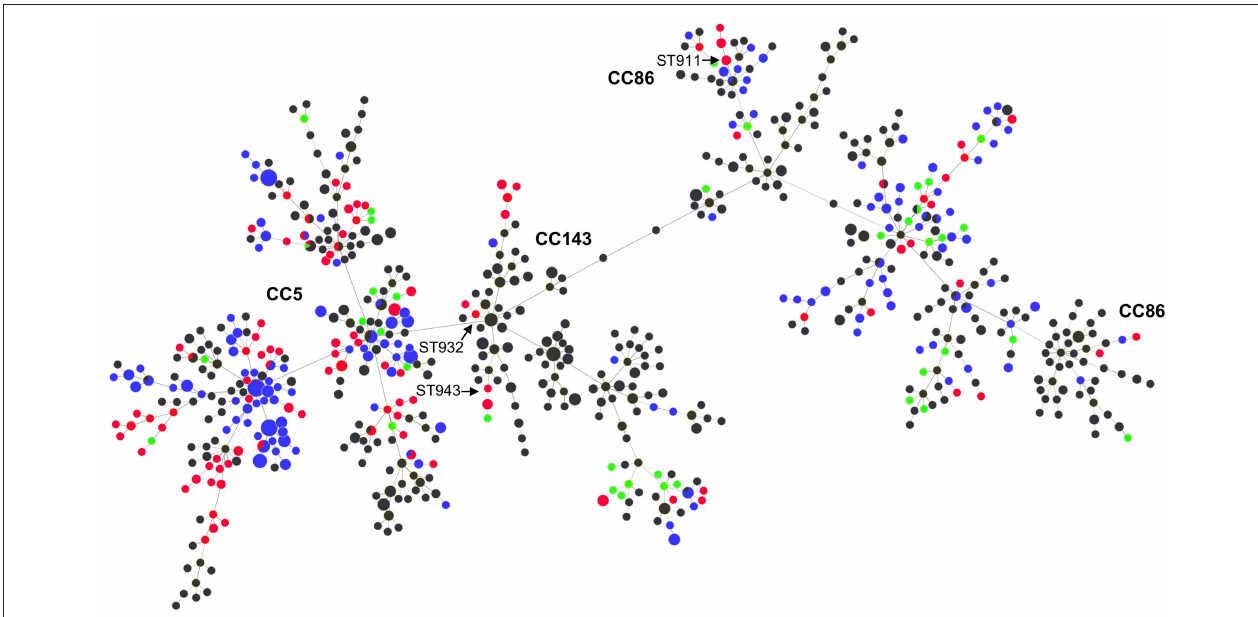
FIGURE 2 | MLST-based minimal spanning tree of all S. uberis isolates in the S. uberis MLST database (pubmlst.org/suberis). Node colors refer to origin of isolates: this study (red), Switzerland during 2008 (green), UK (blue), other countries (dark gray). Node sizes reflect the number of isolates with specific ST. Clonal complexes are indicated in bold. STs from this study that are discussed in the main text are indicated with arrows.